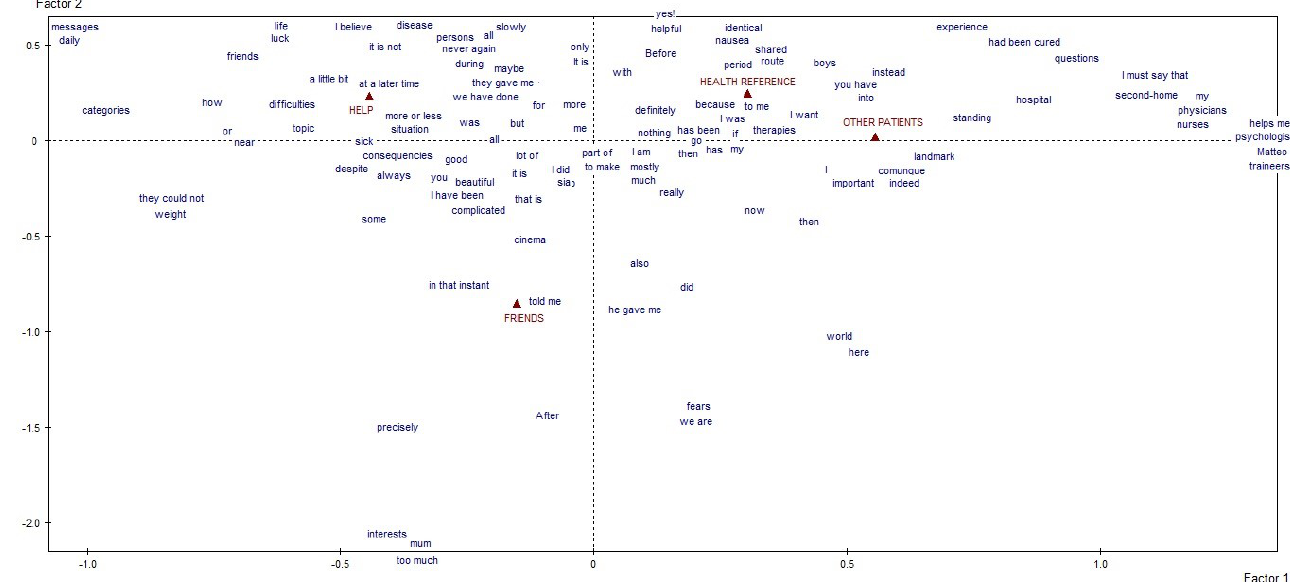
Figure 3. Graphic representation of the third outcome, about “other meanings taking shape along the treatment